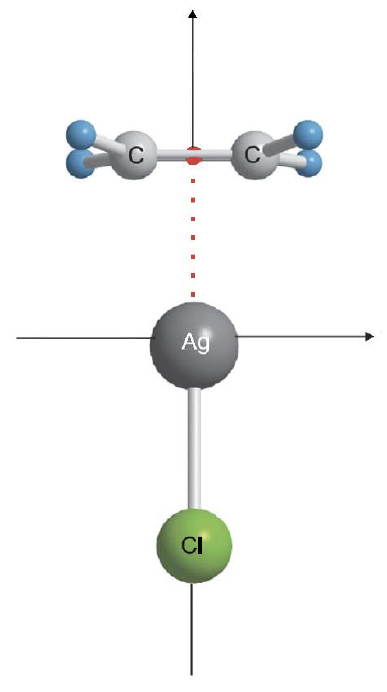
Figure 4. Experimental microwave (MW) structure of complex C 2 H 4 ···Ag – Cl.